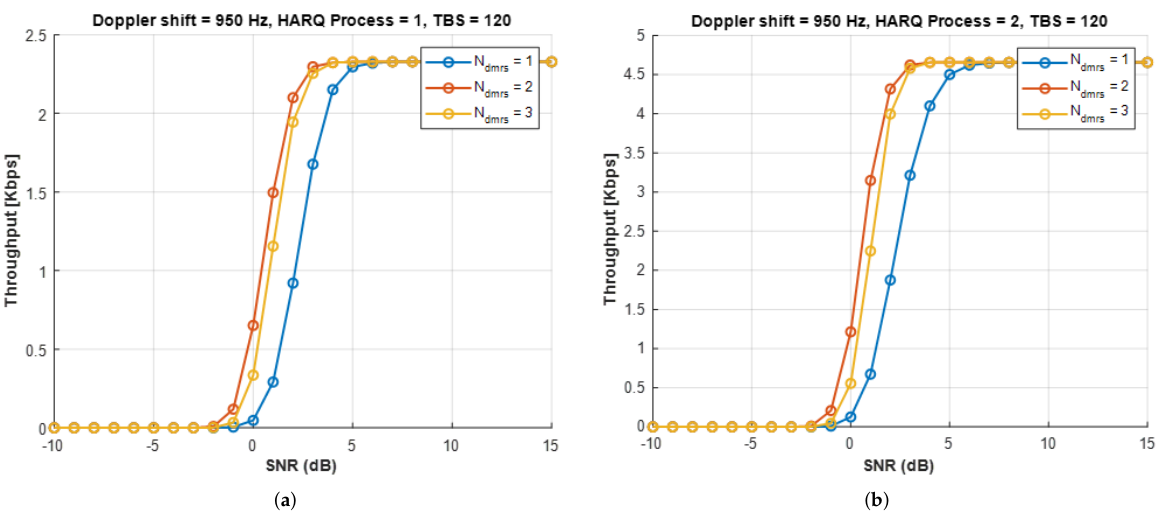
Figure 13. Uplink throughput for different numbers of DMRS symbols per slot with one or two HARQ processes. ( a ) One HARQ process, ( b ) Two HARQ